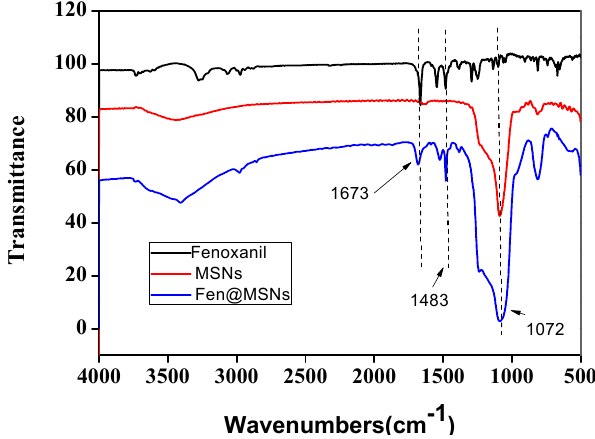
Figure 4. Nitrogen adsorption–desorption isotherms of MSNs and Fen@MSNs.